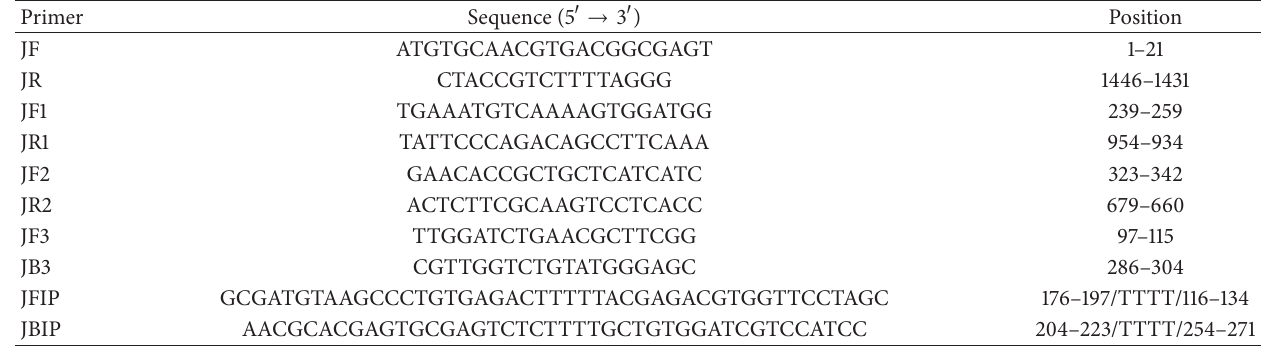
Table 1: Primer names and sequences used in the study.